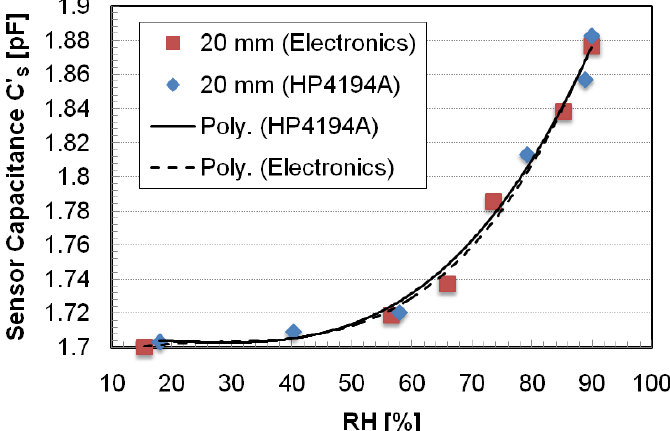
Figure 6. Capacitance values calculated using the proposed conditioning electronics as a function of RH and